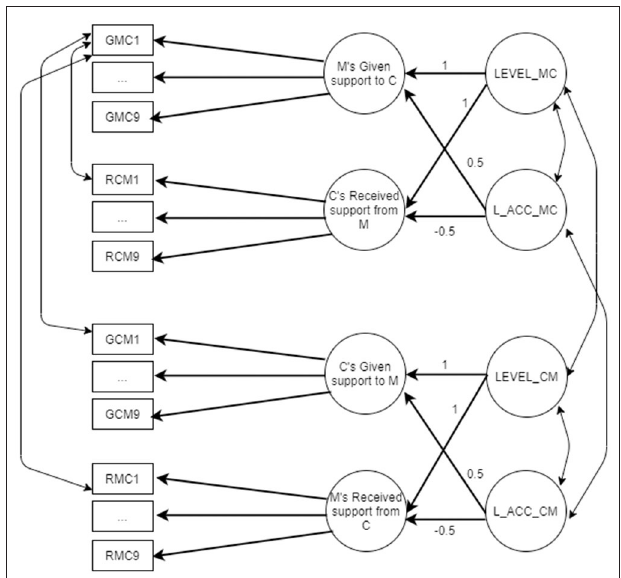
FIGURE 3 | Accuracy LCM referred to mother–child relationship M, mother; C, child. GMC1–GMC9, items assessing the support given by